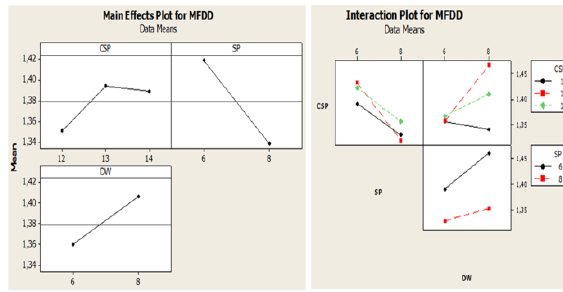
Figure 3. Main effects and interaction plot for MFDD.